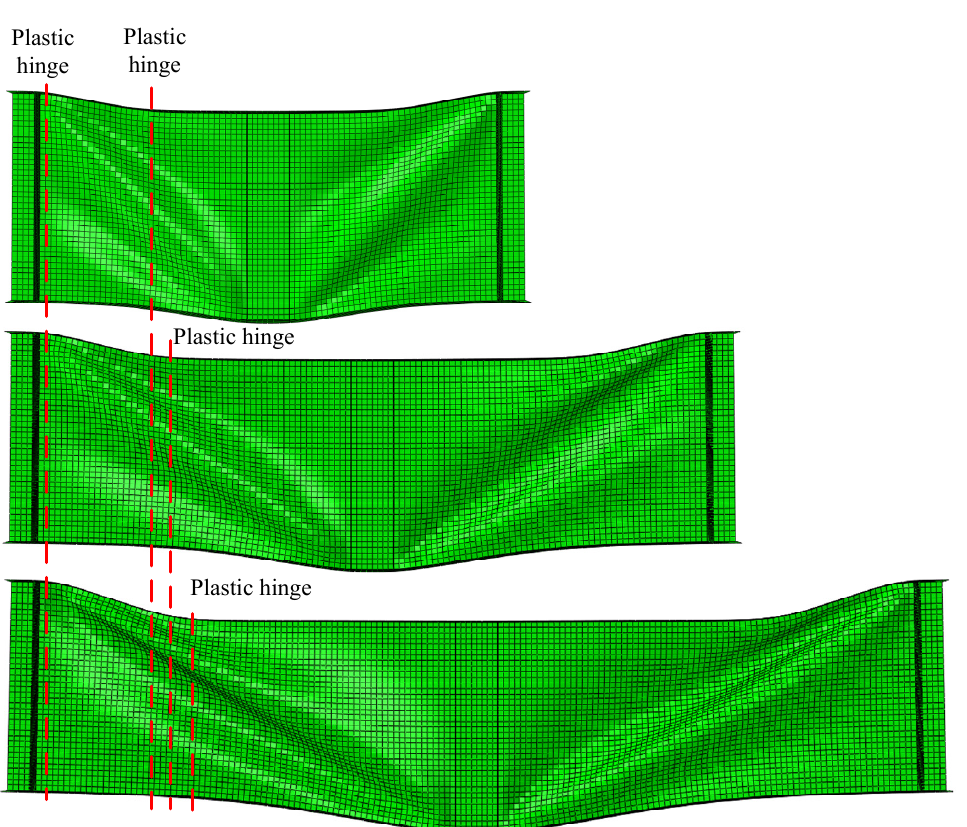
Figure 16. Failure behaviors of the P1 plate girders for 1-150-35, 1.5-150-35, and 2-150-35.